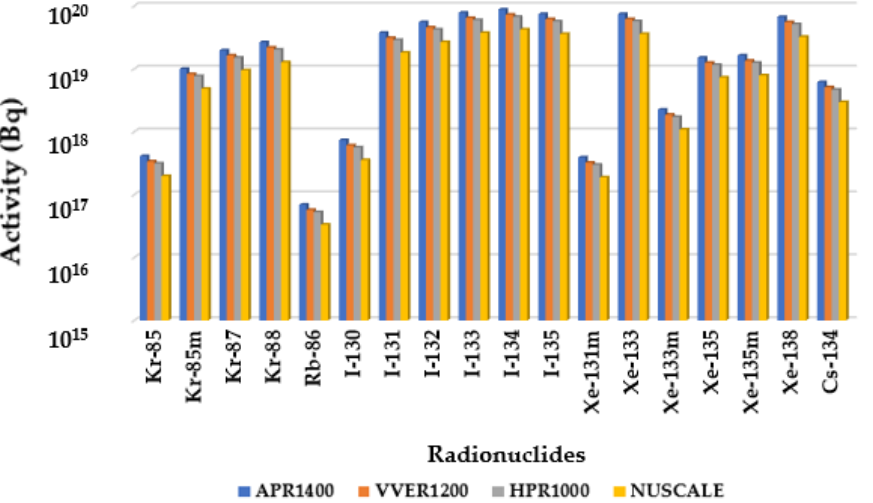
Figure 1. Comparison of rod ejection accident source term activity inventory in becquerels.